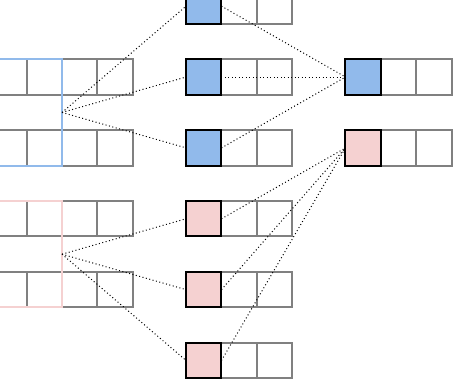
(b) Learning Truth Table Block (LTT) overview: the Conv1D with kernel size = 1 is the amplification layer.